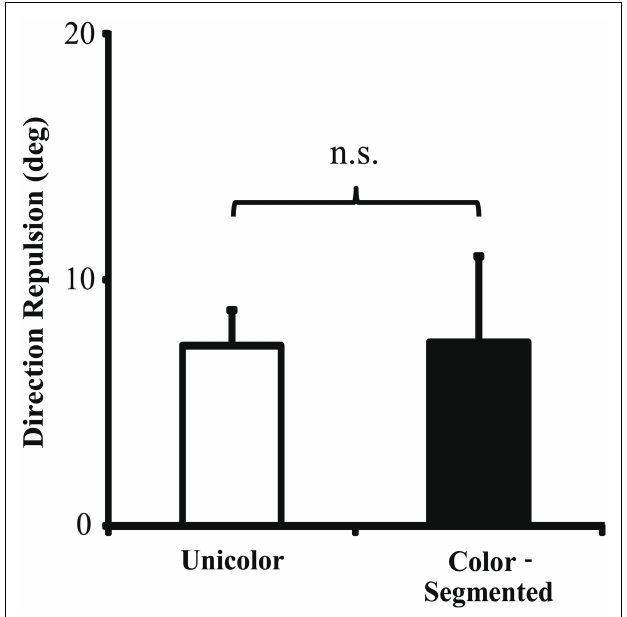
FIGURE 4 | Direction repulsion in Experiment 1. There was no significant change in direction repulsion between the unicolor (7.32 ± 1.45˚) and color-segmented (7.45 ± 3.50˚) paradigms [ t (16) =− 0.04, p = 0.97]. Error bars depict SEM.